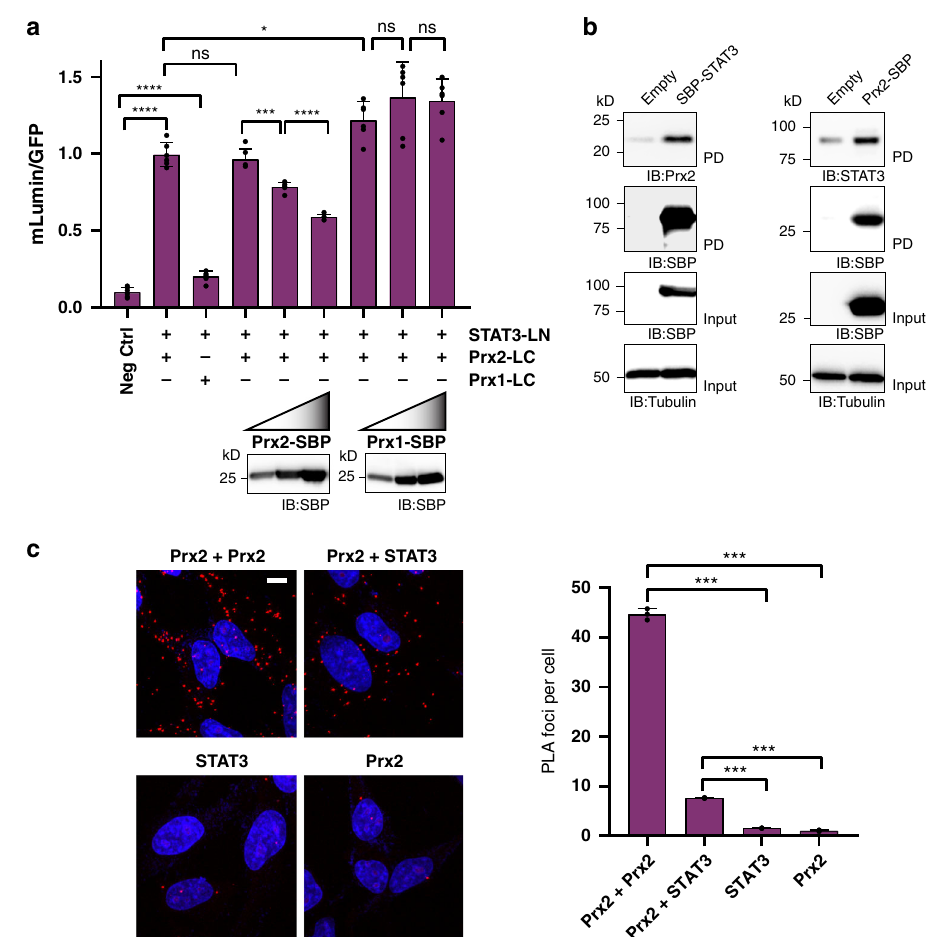
Fig. 1 Peroxiredoxin 2 and STAT3 co-localize independently of and prior to H 2 O 2 -induced disul fi de exchange. a Bimolecular fl uorescence complementation: STAT3-LN interacts more strongly with Prx2-LC than with Prx1-LC (bars 2-3). Fluorescence complementation between STAT3-LN and Prx2-LC can be competed with Prx2-SBP (bars 4 – 6), but not with Prx1-SBP (bars 7 – 9). The negative control (bar 1) indicates non-speci fi c complementation between unfused C- and N-terminal domains of mLumin (LC and LN, respectively). The immunoblots visualize the stepwise increase of Prx2-SBP and Prx1- SBP expression. Based on n = 6 independent experiments with n = 6 technical replicates each. IB: immunoblot. Source data are provided as a Source data fi le. b Co-precipitation: SBP-STAT3 co-precipitates Prx2 (left panels), and Prx2-SBP co-precipitates STAT3 (right panels). Blots are representative of n = 5 independent experiments. PD pulldown; IB immunoblot. Source data are provided as a Source data fi le. c Proximity ligation: Endogenous (untagged) Prx2 and STAT3 form a complex. Representative images (left panels) show PLA foci in red and DAPI in blue. The Prx2-Prx2 interaction (homo-oligomer formation) was used as a positive control, and single antibody experiments were included as negative controls. Scale bar: 10 µ m. The bar graph (right panel) quanti fi es the number of PLA foci per cell ( n = 50 – 60 cells in two technical replicates). The results are representative of n = 3 independent experiments. All bar charts in this fi gure represent the mean ± SD. * p < 0.05; *** p < 0.001; **** p < 0.0001; ns not signi fi cant; based on a two-tailed unpaired t